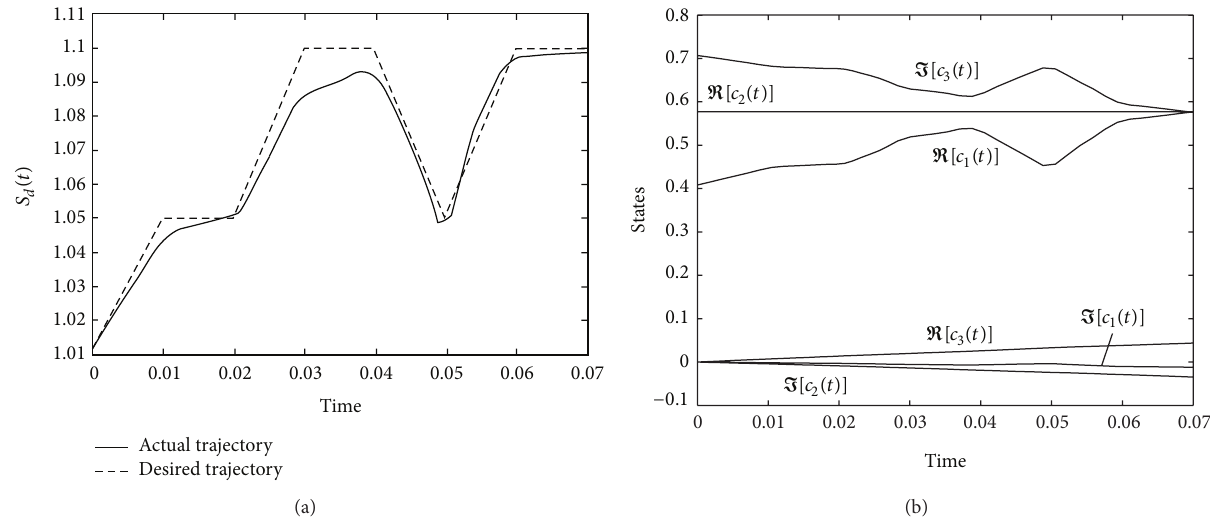
Figure 9: Evolutions of the entropy and states for system (72) under improved controller